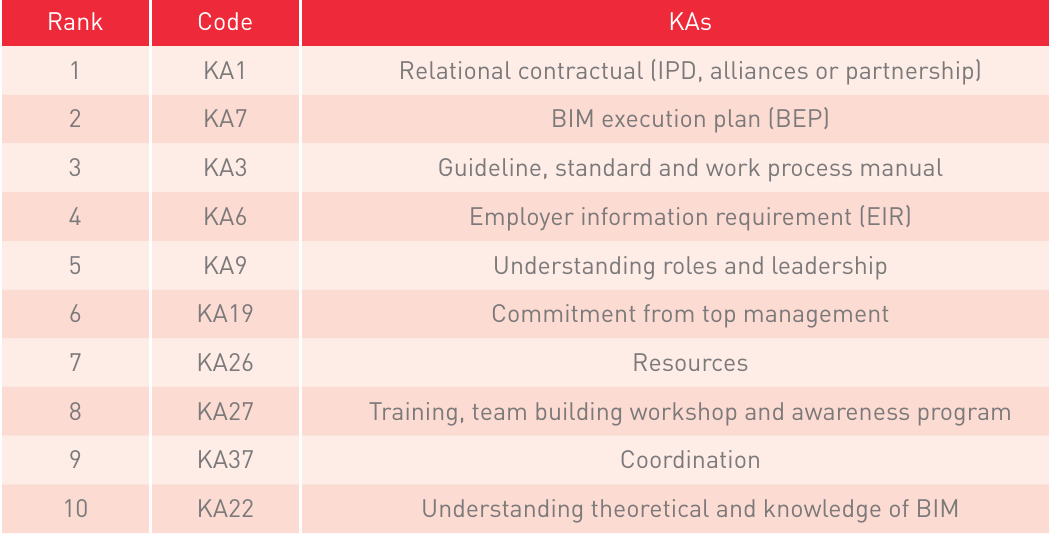
The top ten key attributes of multi-actor social